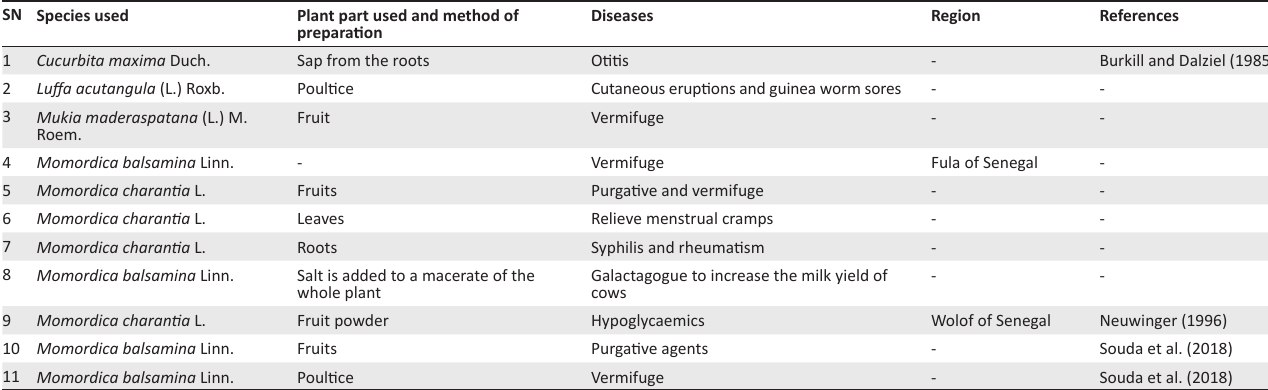
TABLE 6: Cucurbitaceae species used as traditional medicine in Senegal. SN Species used